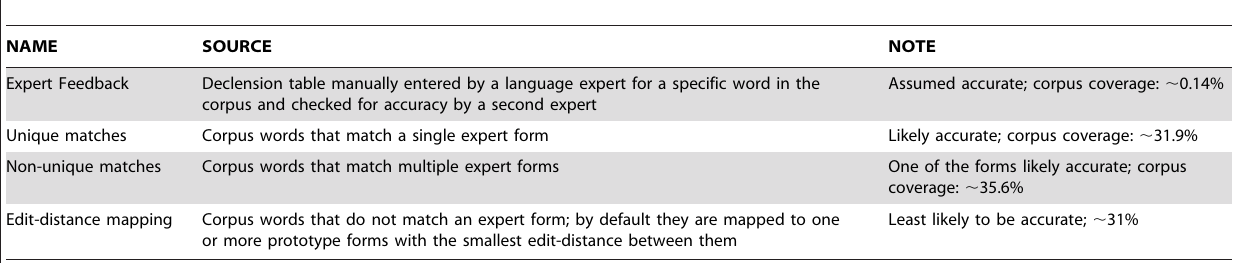
Table 4. Different knowledge